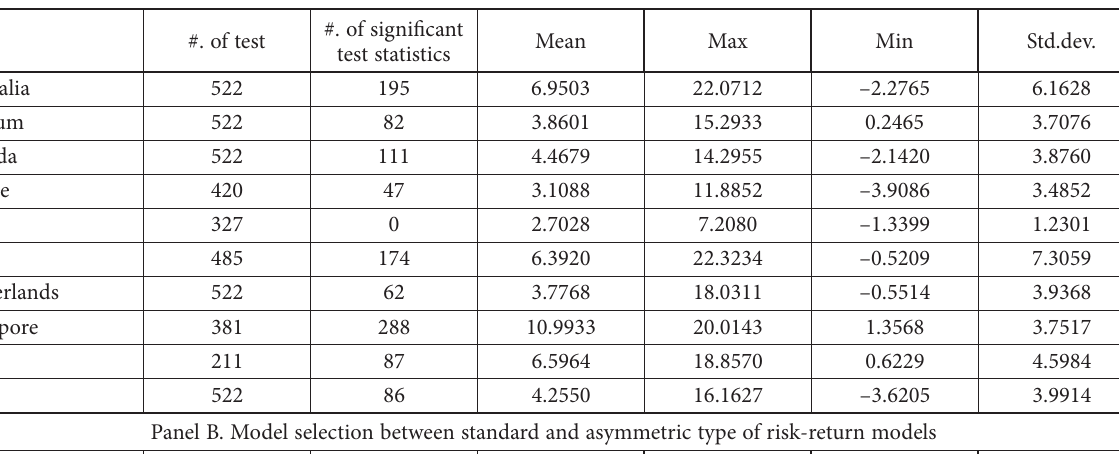
Panel B. Model selection between standard and asymmetric type of risk-return models #. of significant #. of test test